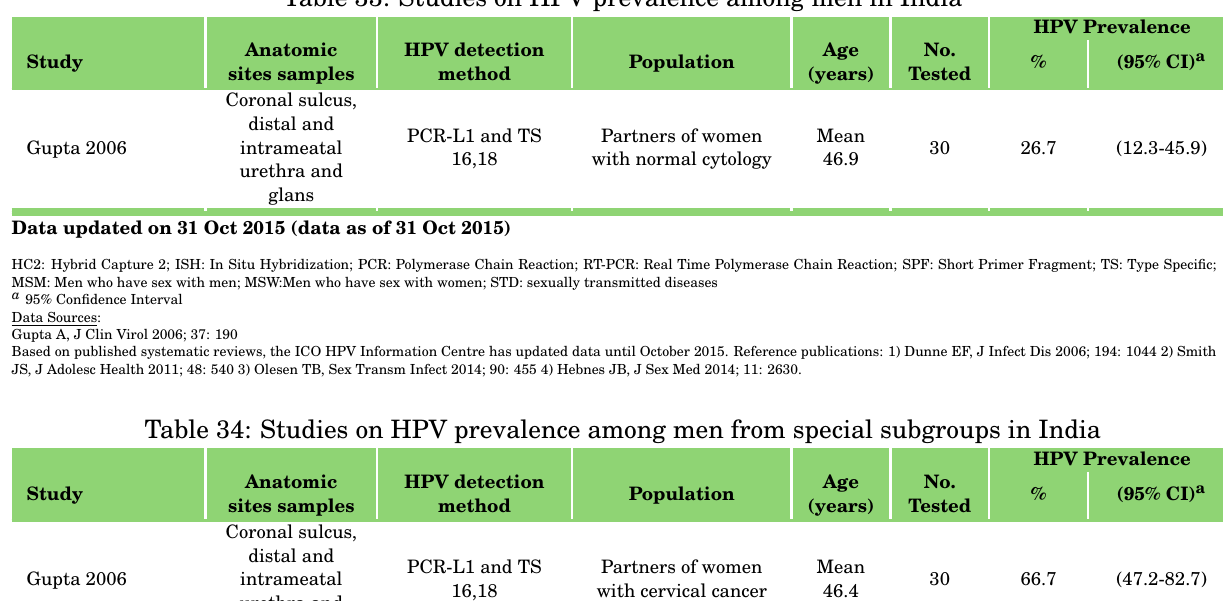
Table 33: Studies on HPV prevalence among men in India